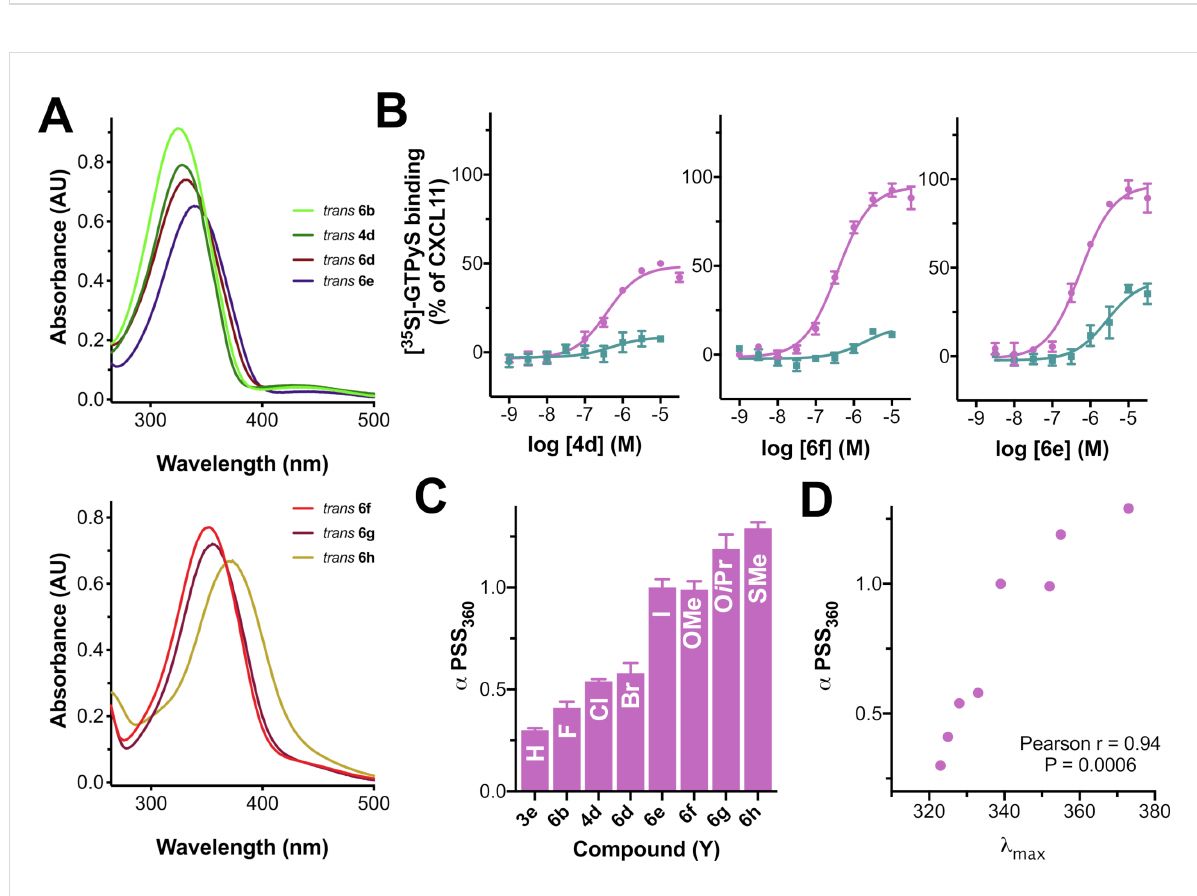
Figure 4: Properties of subseries 3e , 4d , 6b and 6d-h . (A) UV–vis absorption spectra of (top) trans- isomers of 6b , 4d , 6d and 6e (having substituent Y = F, Cl, Br and I, respectively) and (bottom) 6f , 6g and 6h (having Y = OMe, OiPr and SMe, respectively). (B) Functional dose-response